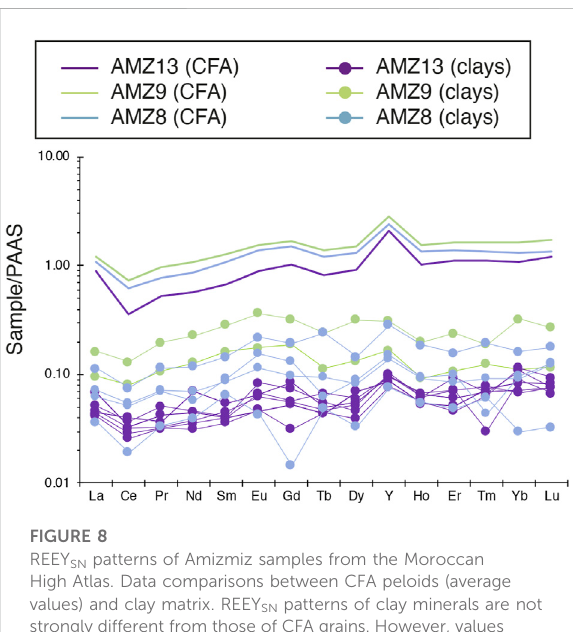
FIGURE 8 REEY SN patterns of Amizmiz samples from the Moroccan High Atlas. Data comparisons between CFA peloids (average values) and clay matrix. REEY SN patterns of clay minerals are not strongly different from those of CFA grains. However, values are, at least, ten times lower. PAAS values are from Taylor and McLennan